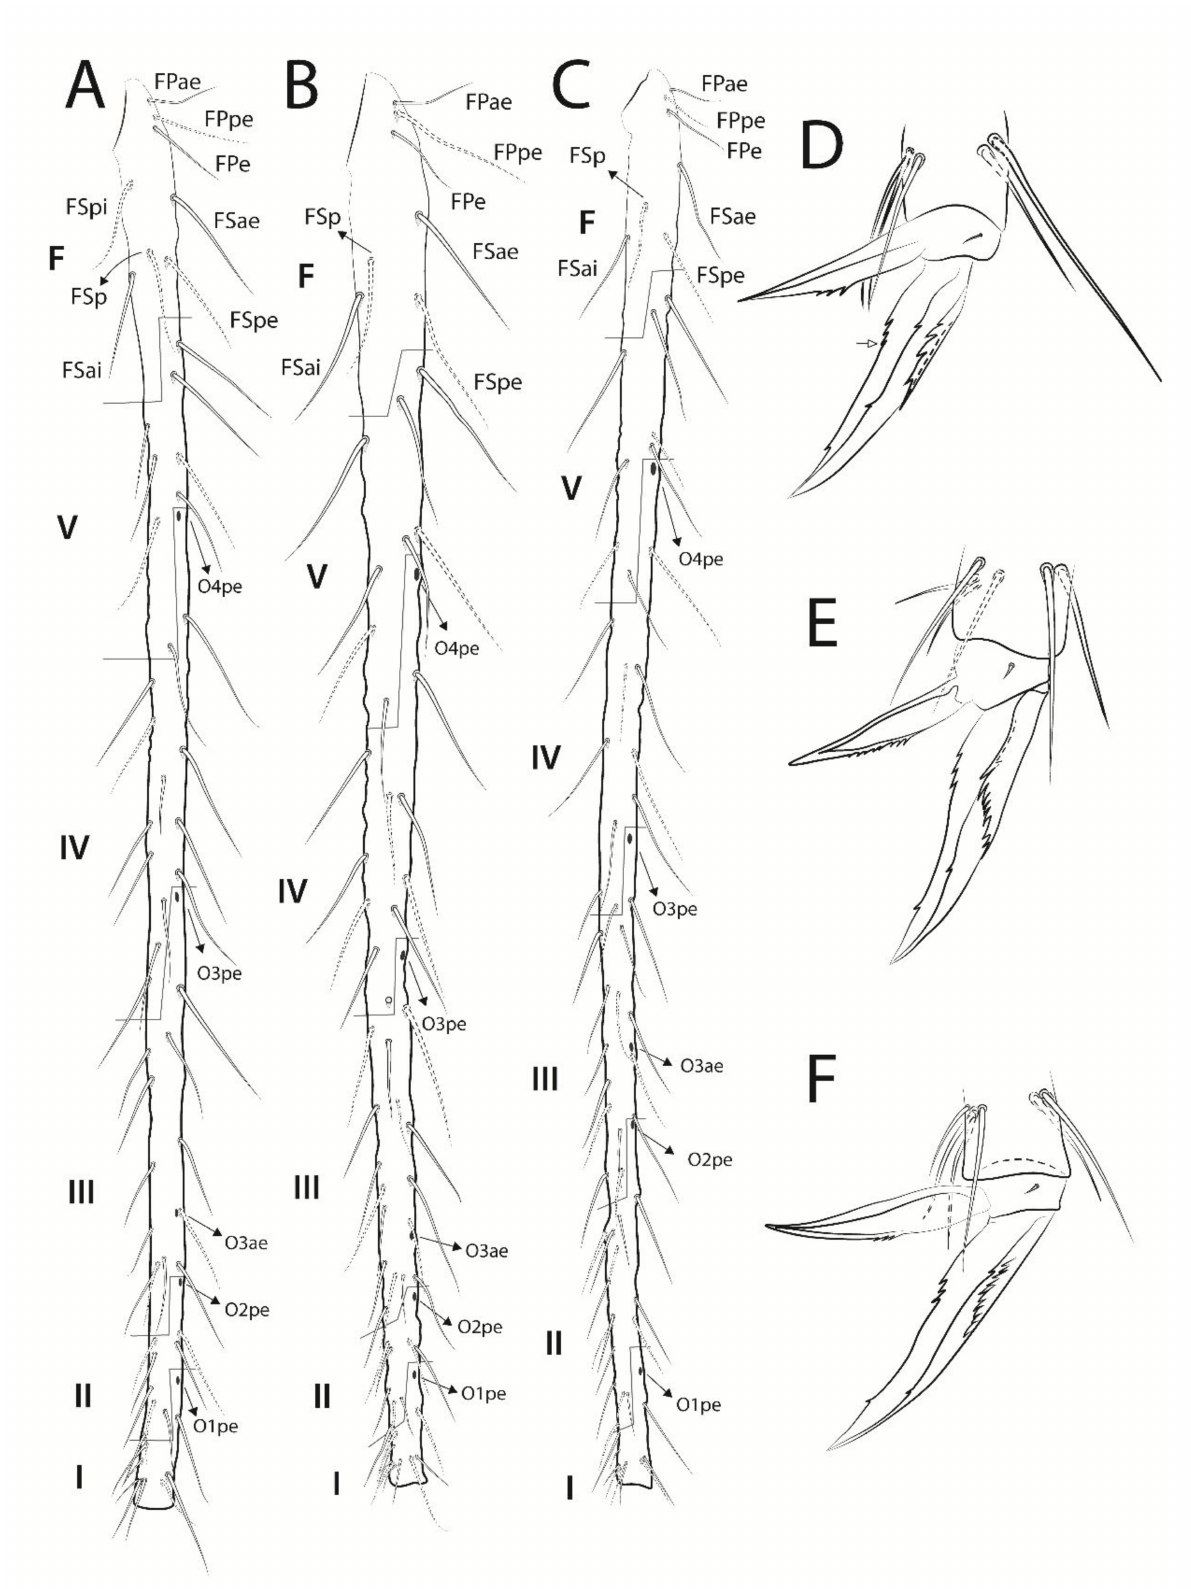
Figure 8. Troglobentosminthurus luridus gen. nov. sp. nov. legs: ( A ) tibiotarsus I; ( B ) tibiotarsus II; ( C ) tibiotarsus III; ( D ) empodial complex I, anterior view, white arrow marks a ungual tooth which can be absent; ( E ) empodial complex II, anterior view; ( F ) empodial complex III, anterior